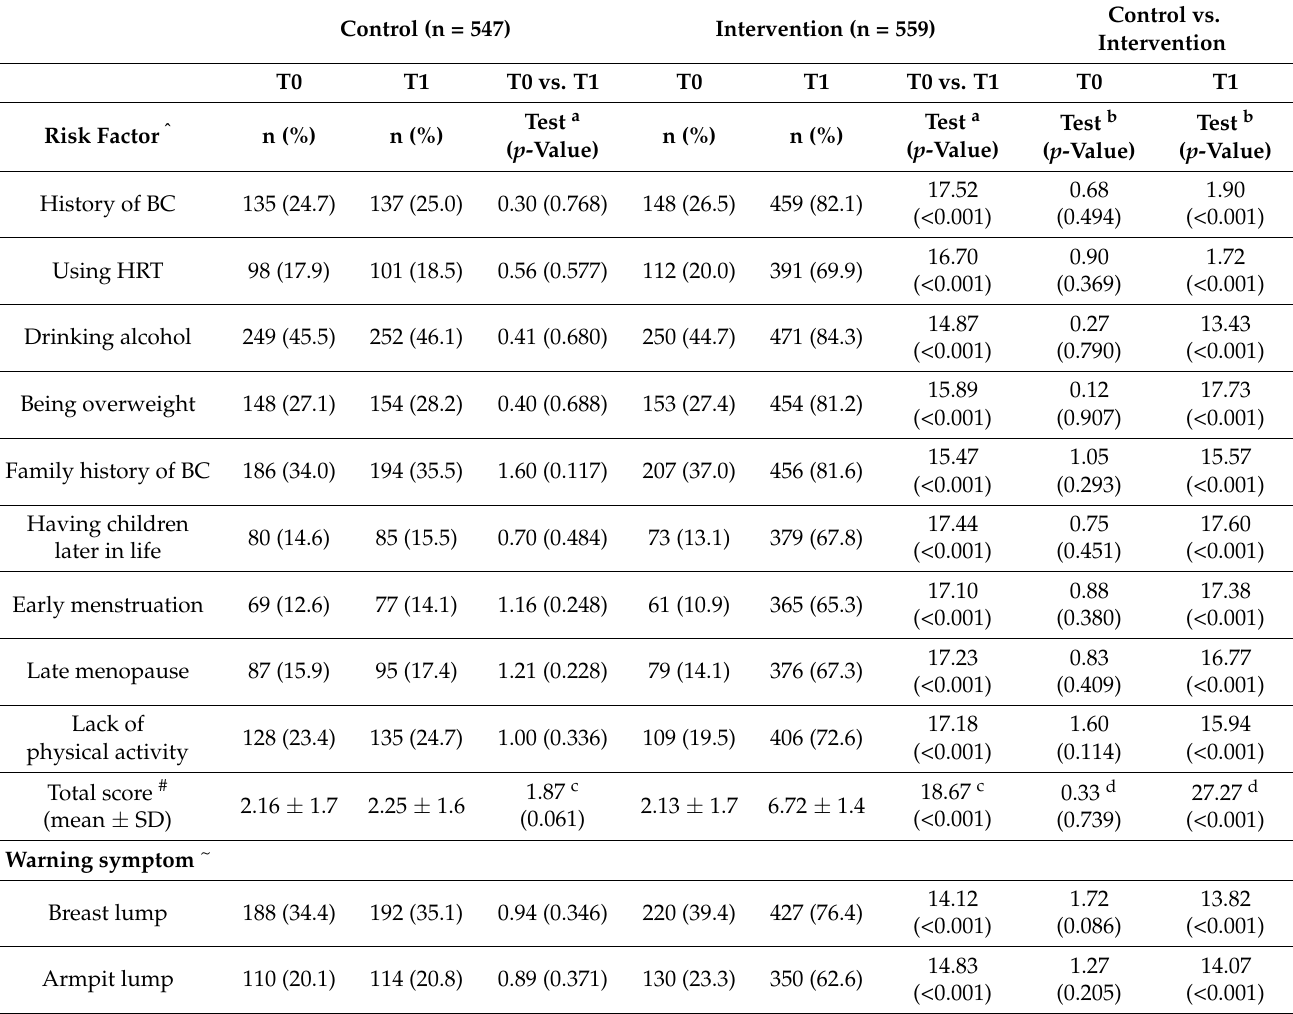
Table 2. Comparison of knowledge of breast cancer risk factors and warning symptoms between groups at baseline (T0) and four weeks later (T1) (N = 1106). Control (n = 547) Intervention (n = 559)